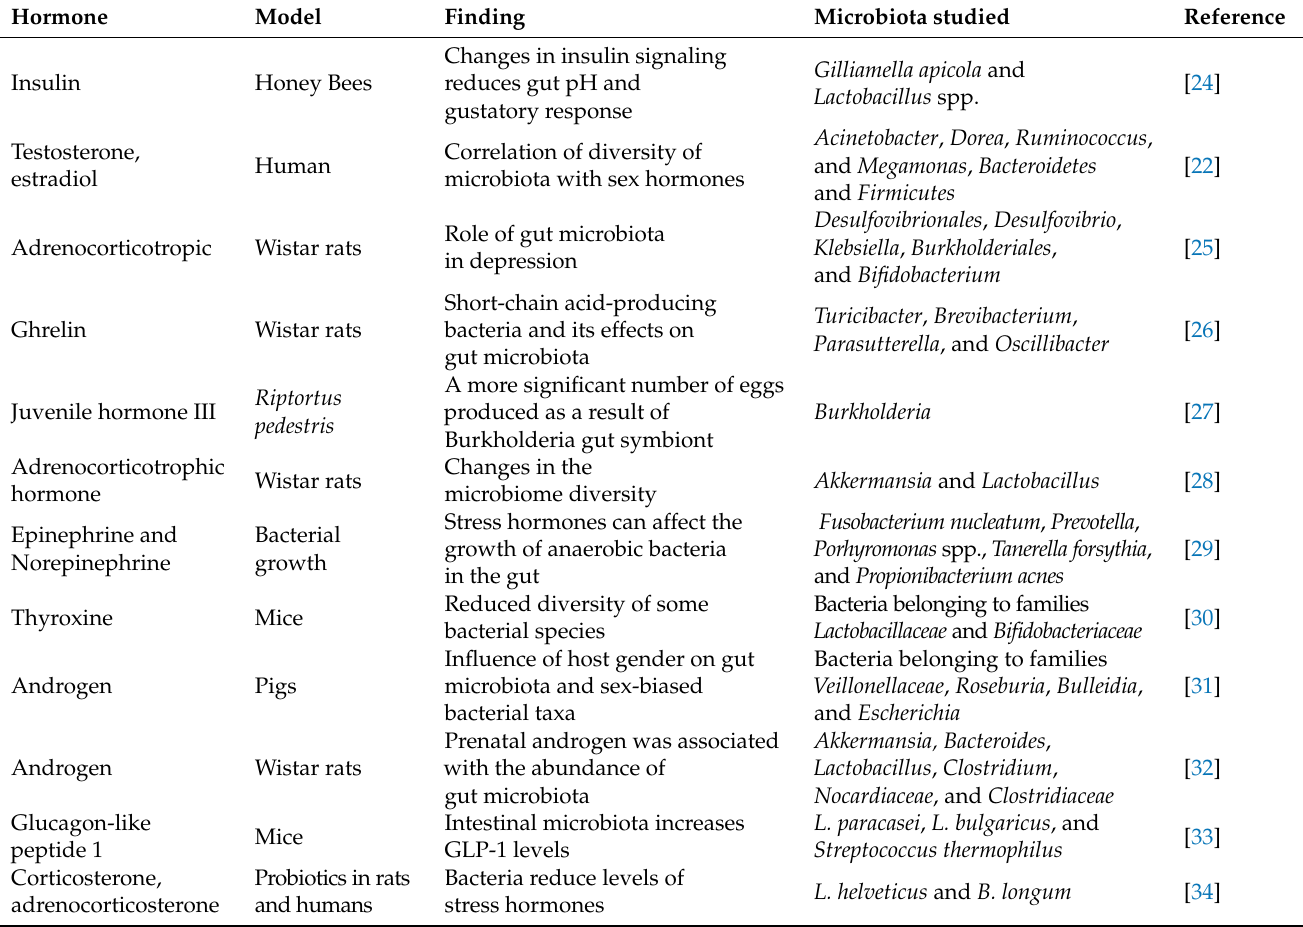
Table 1. Recent studies on gut microbiota and endocrine